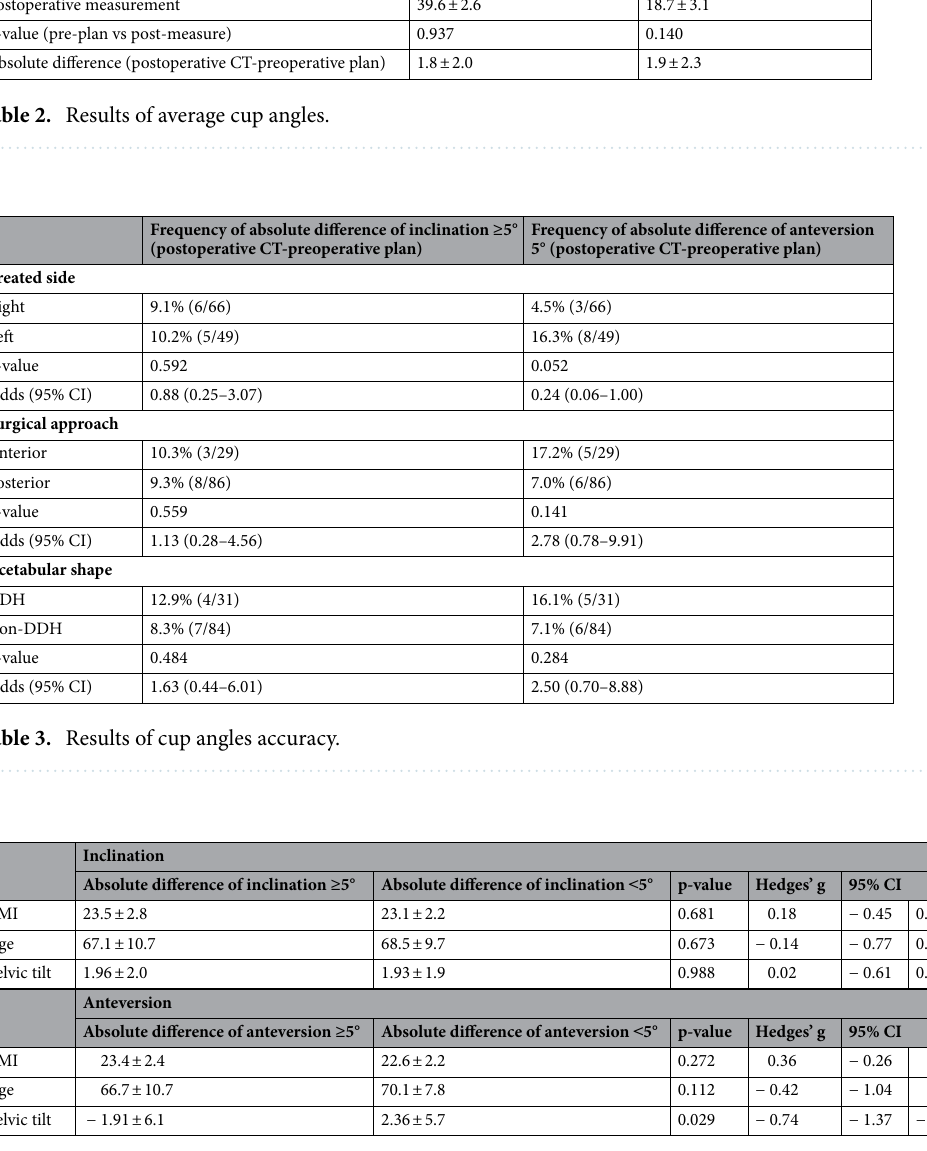
Table 4. Results of cup angles